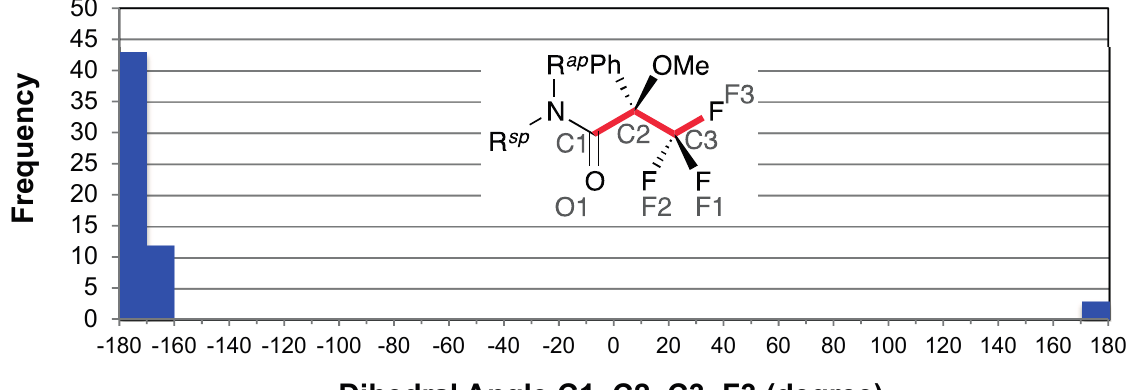
Figure 4. Histogram for dihedral angles C1–C2–C3–F3 of all MTPA amides. F3 is the fluorine atom ap to C1. The possible range of the dihedral angle C1–C2–C3–F3 is from − 180° to − 120° and from +120° to